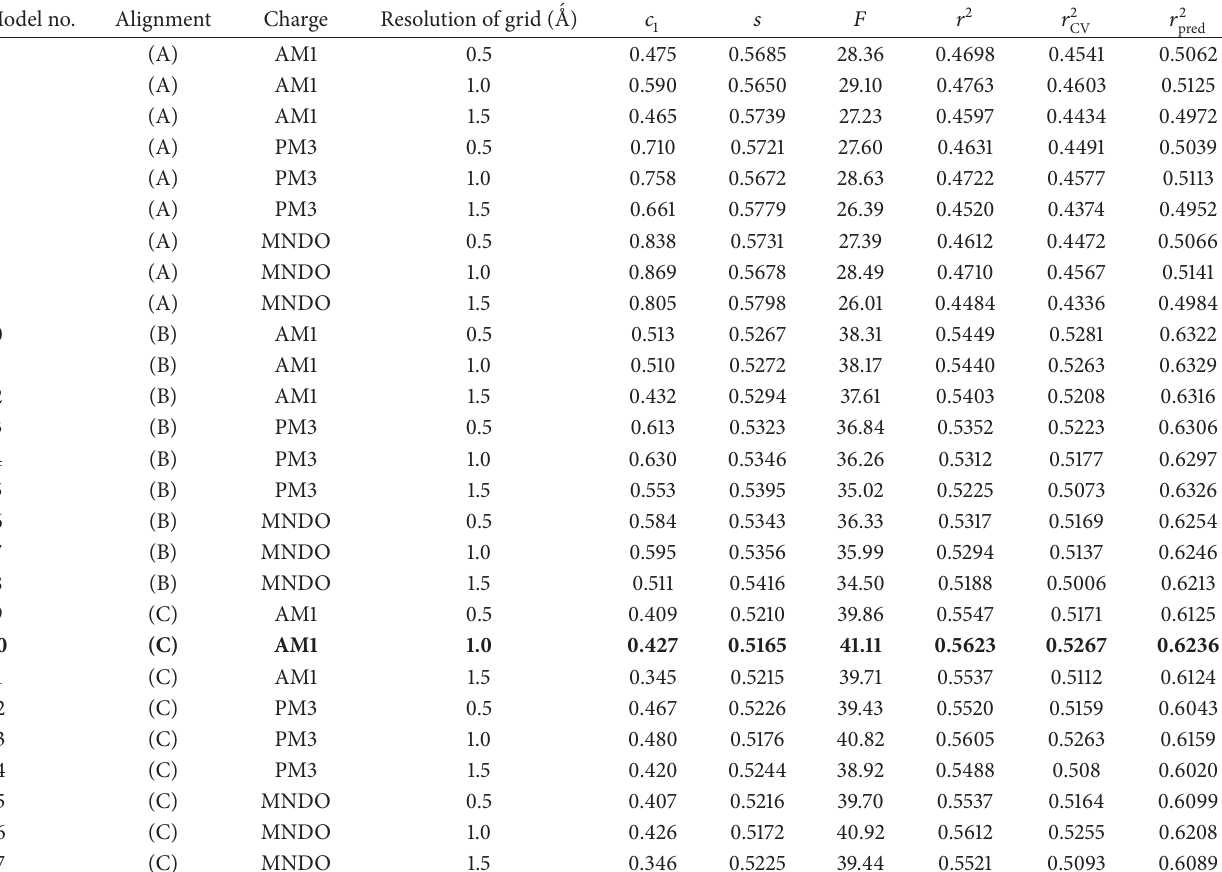
Figure 3: Superposition of compouds of using alignment C, based on docking. (a) Thirty-four analogues in the active site of VEGFR-2; (b) superposition of compouds in training and test sets. Table 2: Statistical results of the various SOMFA